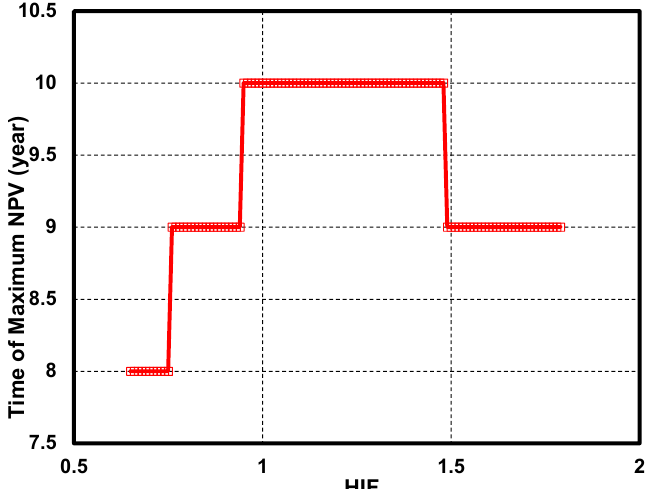
Figure 6. Commercial cut-off years after production versus Heterogeneity Impact Factor.